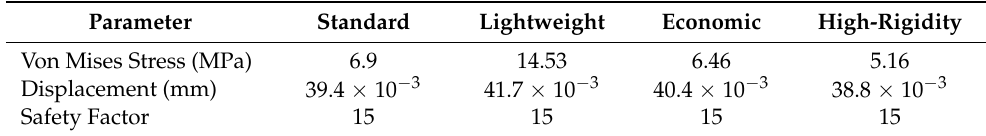
Table 6. Static Simulation Result of Cantilever Crane Frame